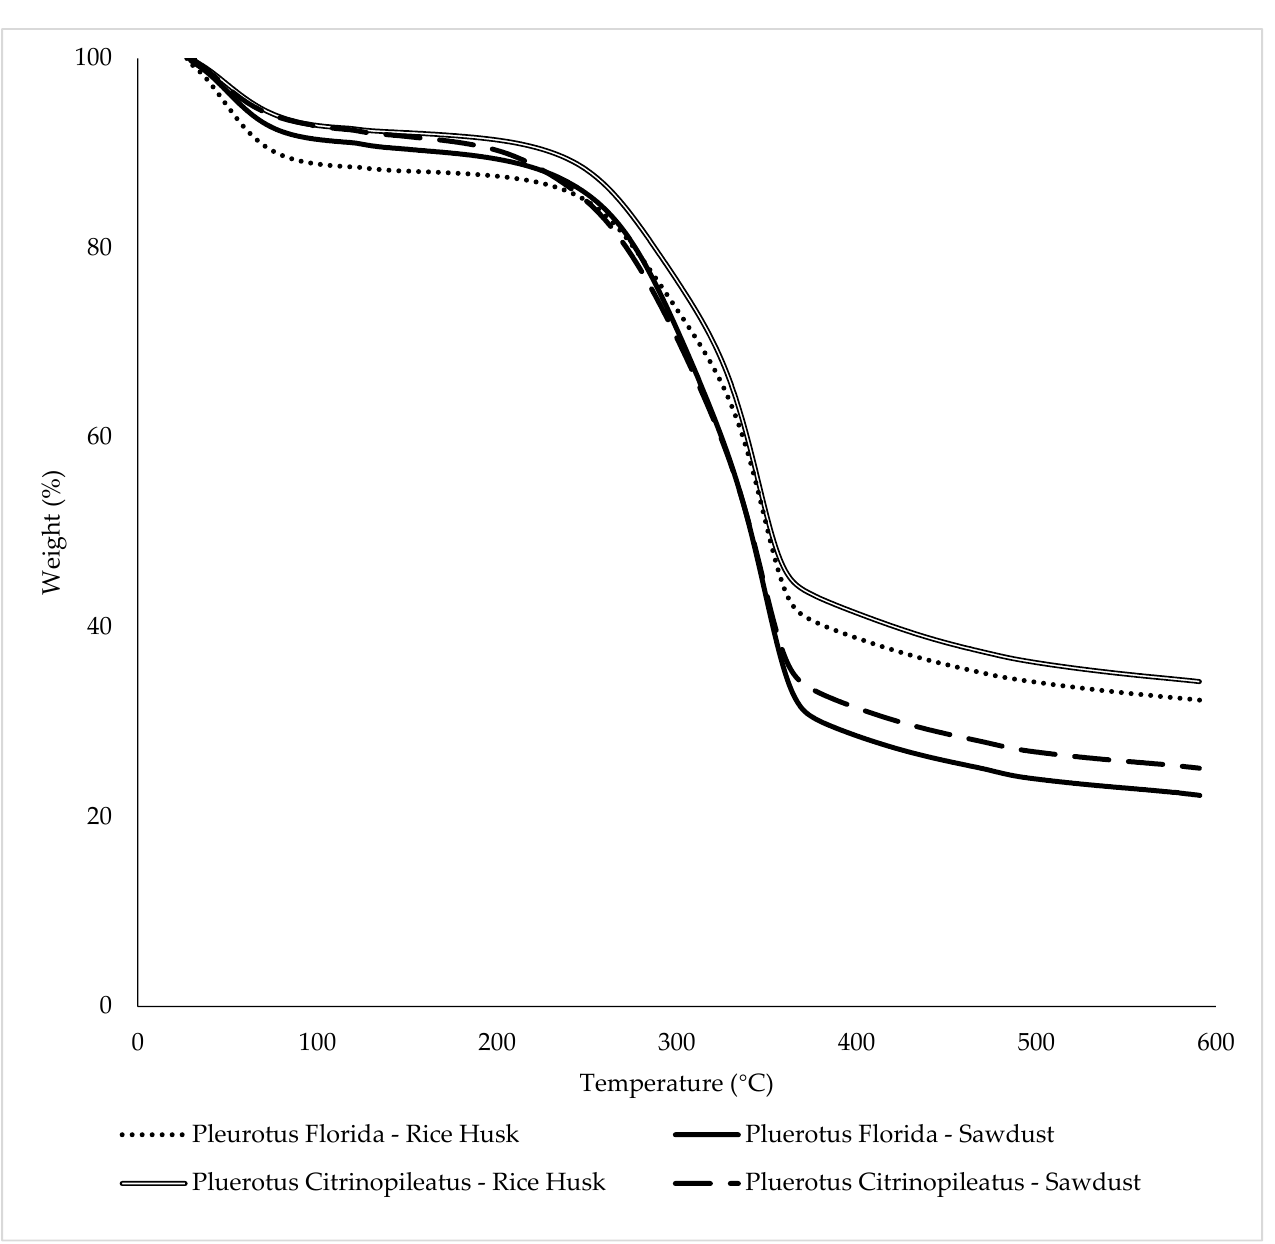
Figure 8. Thermogram of fungal foam from Pleurotus florida and Pleurotus citrinopileatus with varying substrates.